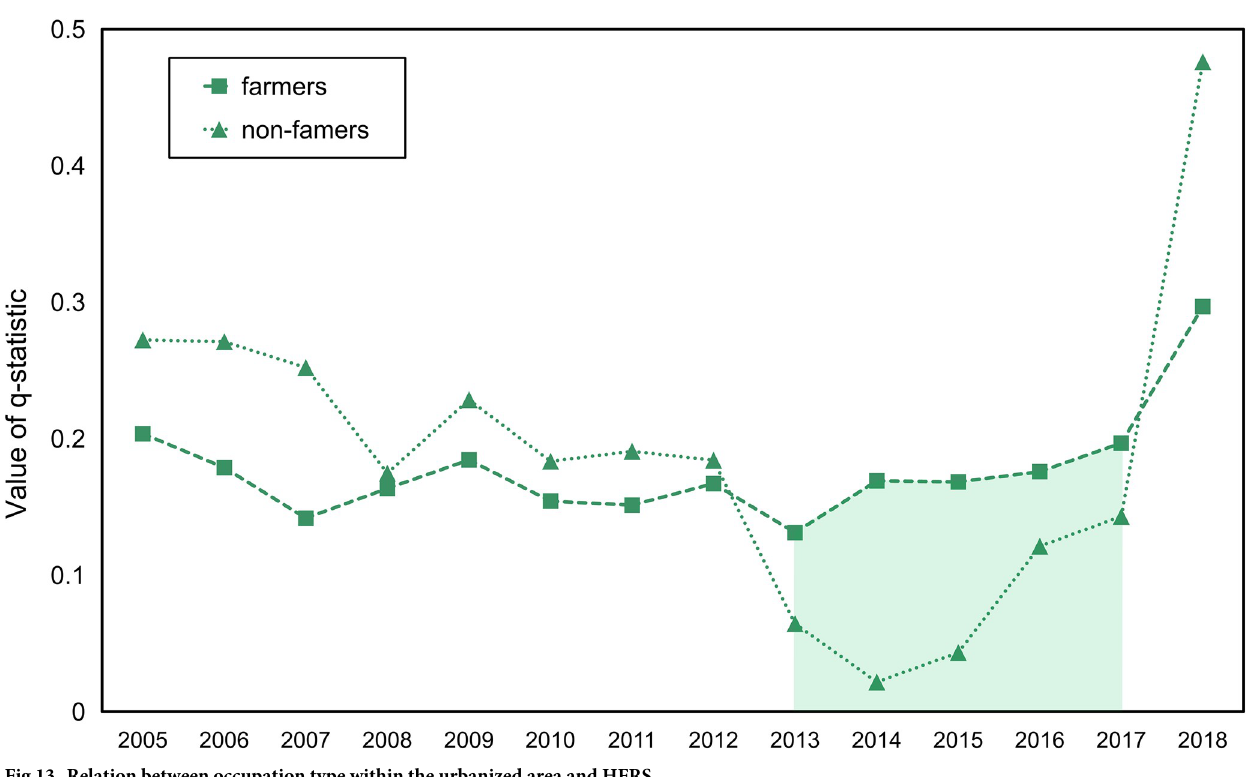
Fig 13. Relation between occupation type within the urbanized area and